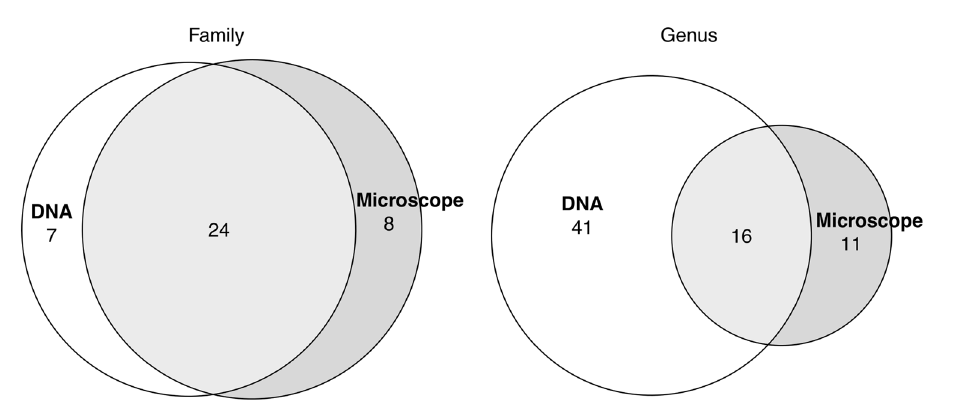
Figure 4. Venn diagrams with the number of families found by DNA metabarcoding and microscope and the common genera from those families as detected during March–July